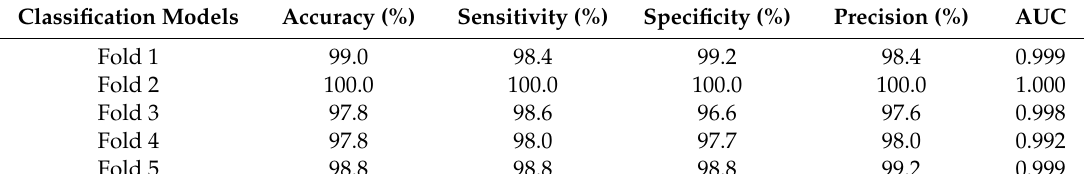
Table 8. Performance evaluation of the VGG19 and VGG16 models for predicting mild-ROP and severe-ROP.